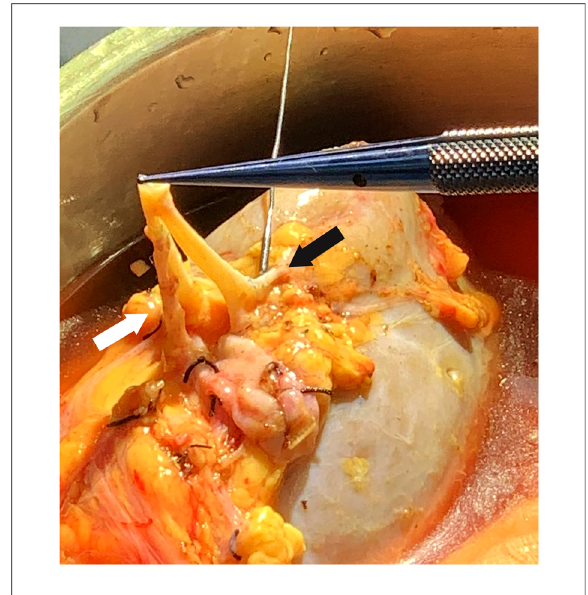
FIGURE 1 Adult allograft with two renal arteries reconstructed into a single ori fi ce using polypropolene 8-0 and 2.5×